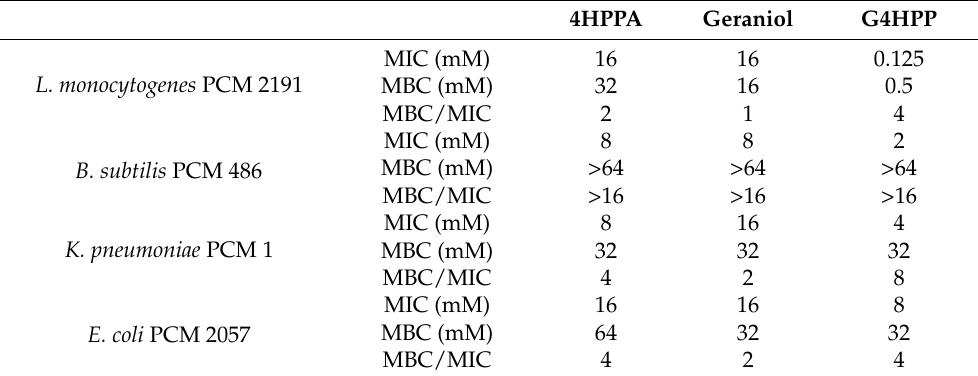
Table 5. Comparison of antibacterial activity of synthesized ester and its